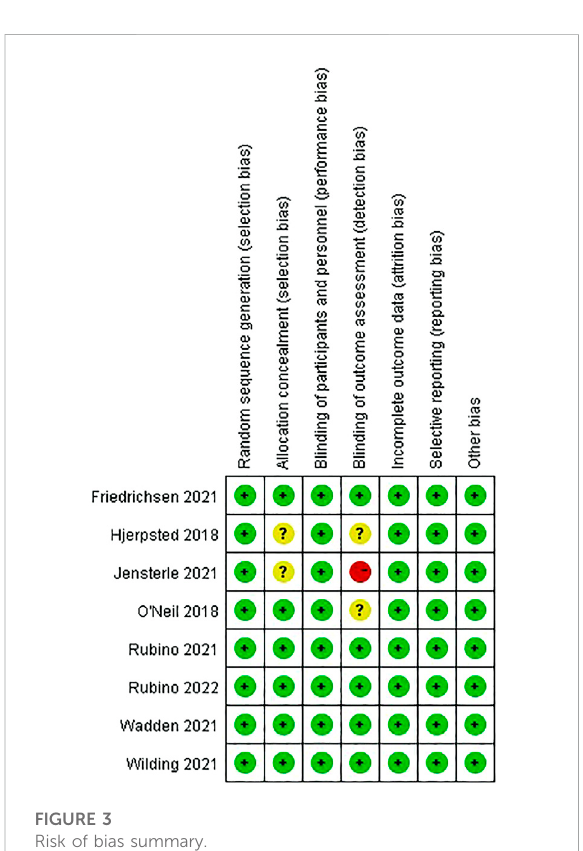
FIGURE 3 Risk of bias